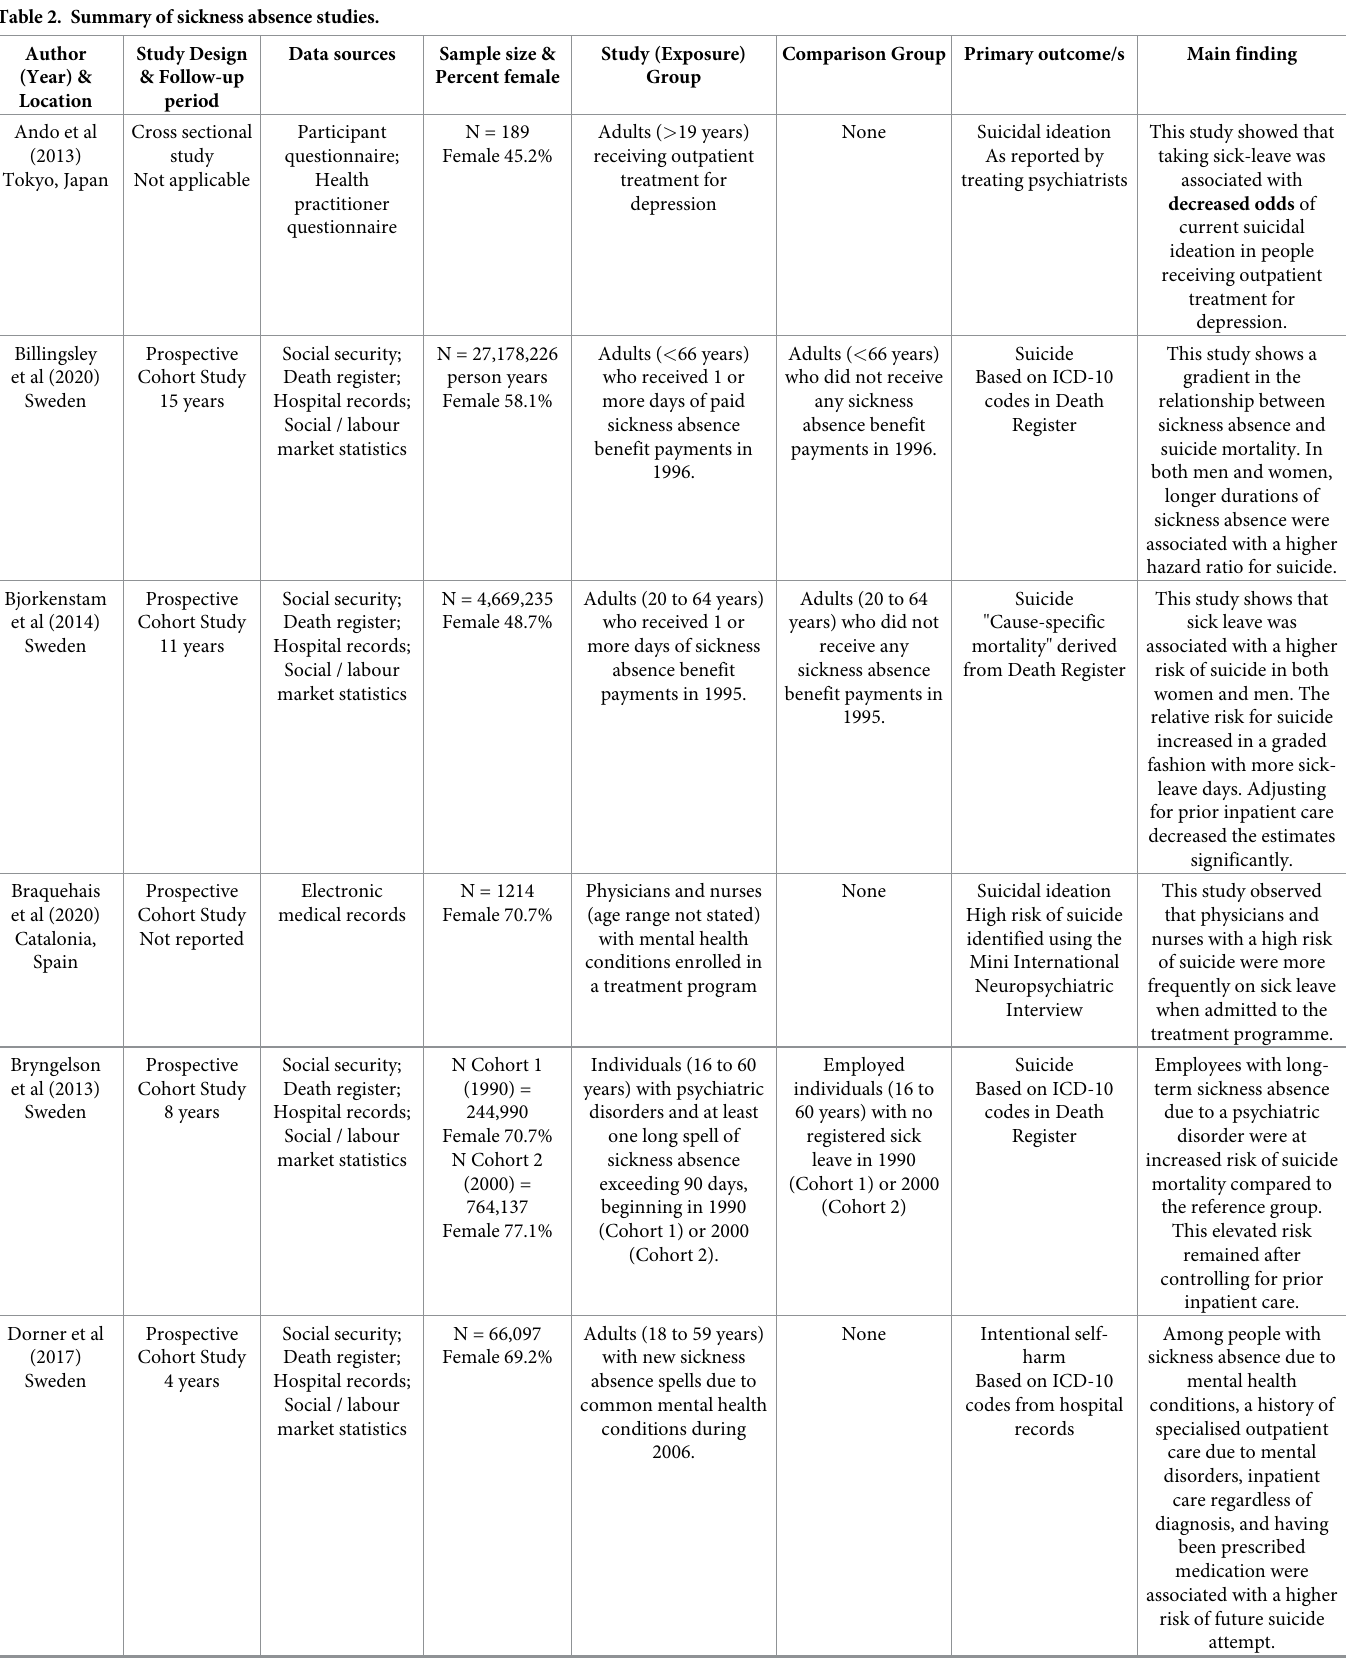
Table 2. Summary of sickness absence